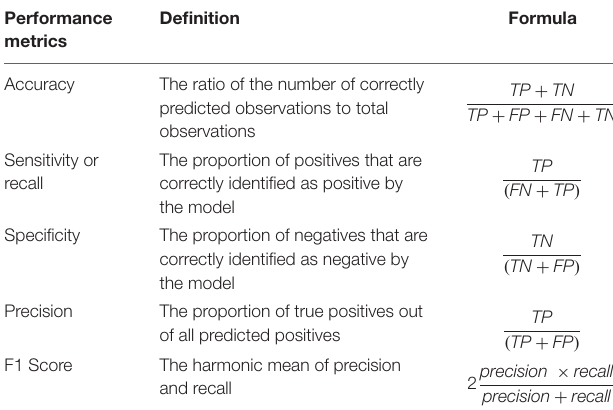
TABLE 3 | Performance